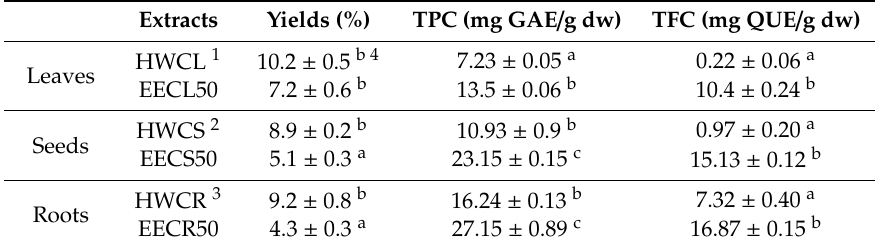
Table 3. Yields, total polyphenol (TPC) and flavonoid (TFC) contents of hot water and 50% ethanol extracts from various parts of C. cajan .